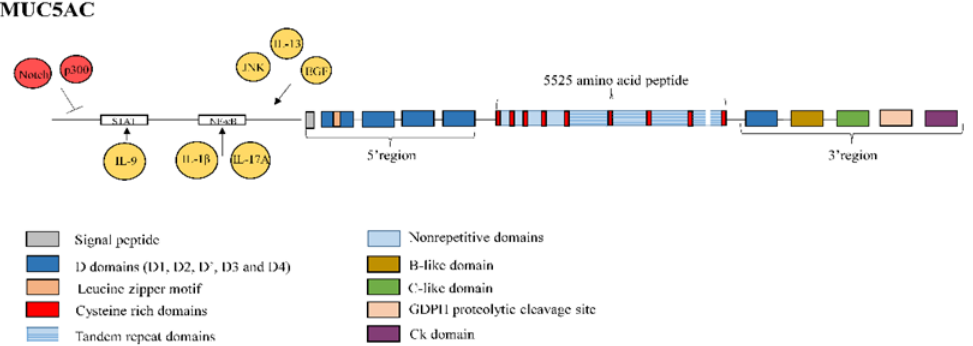
Figure 4. Structure of mucin MUC5AC. MUC5AC is a polymeric mucin made of 5,525 amino